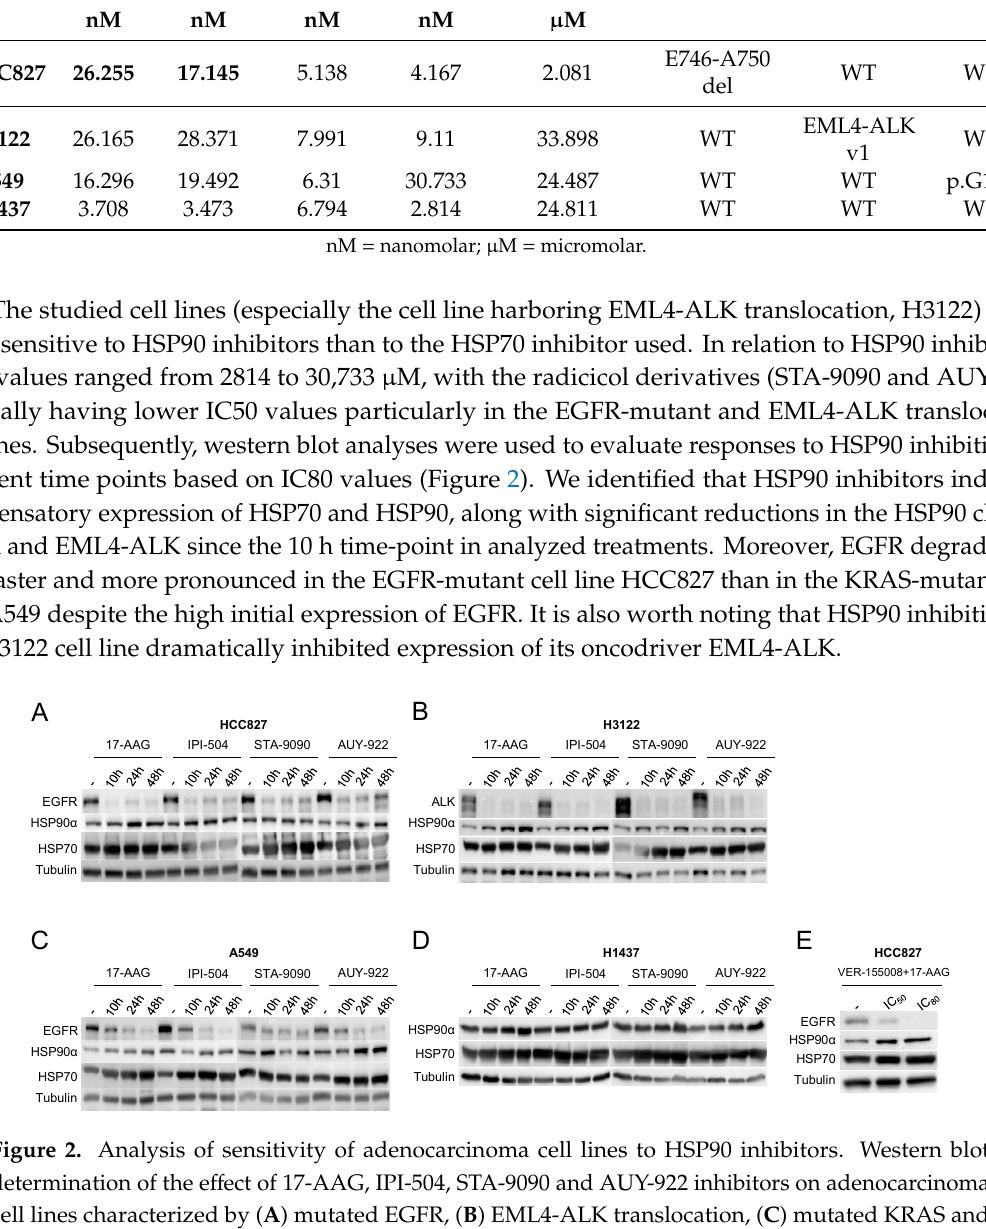
Table 1. IC50 values of different HSP90 and HSP70 inhibitors in the studied cell lines.